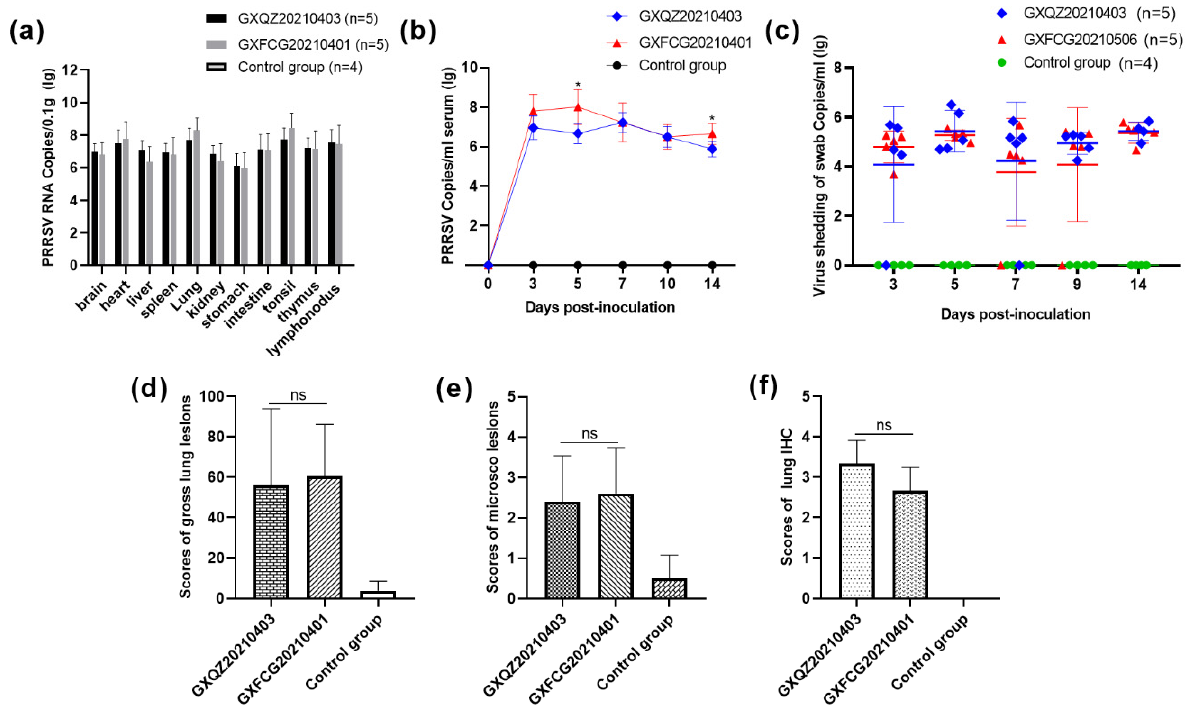
Figure 7. ( a ) Determination of RNA copy numbers of PRRSVs for different organs of the piglets in each group, as measured by qRT-PCR. ( b ) The number of PRRSV RNA copies in the sera of pigs on different days after the challenge were quantified by qRT-PCR. ( c ) The nasal and rectal swabs were collected on different days to detect virus shedding from piglets in each group. ( d ) The scores of lung gross lesions were graded based on the percentage of the lung areas affected. ( e ) The scores of lung microscopic lesions were graded based on the distribution and severity of interstitial pneumonia. ( f ) The scores of the numbers of PRRSV-positive cells in the lungs. The values are expressed as means ± standard deviations, the bars represent the average values and error bars indicate standard deviations. Asterisks indicate the significant differences between the GXFCG20210401- and GXQZ20210403-infected groups when compared to the controls (* p < 0.05; ns, no significant difference).